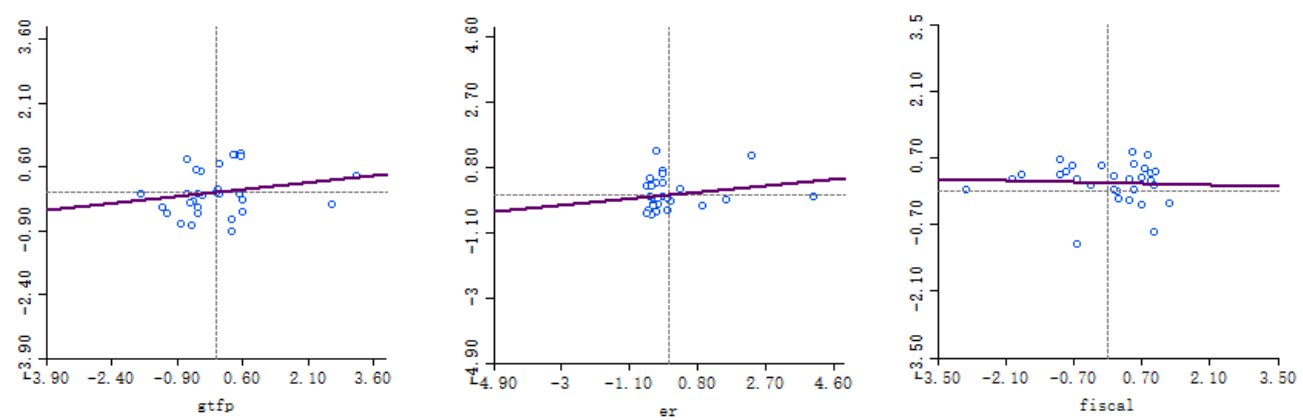
Figure 2. The partial Moran’ I of environmental regulation, financial support for agriculture and agricultural green development in 2020.